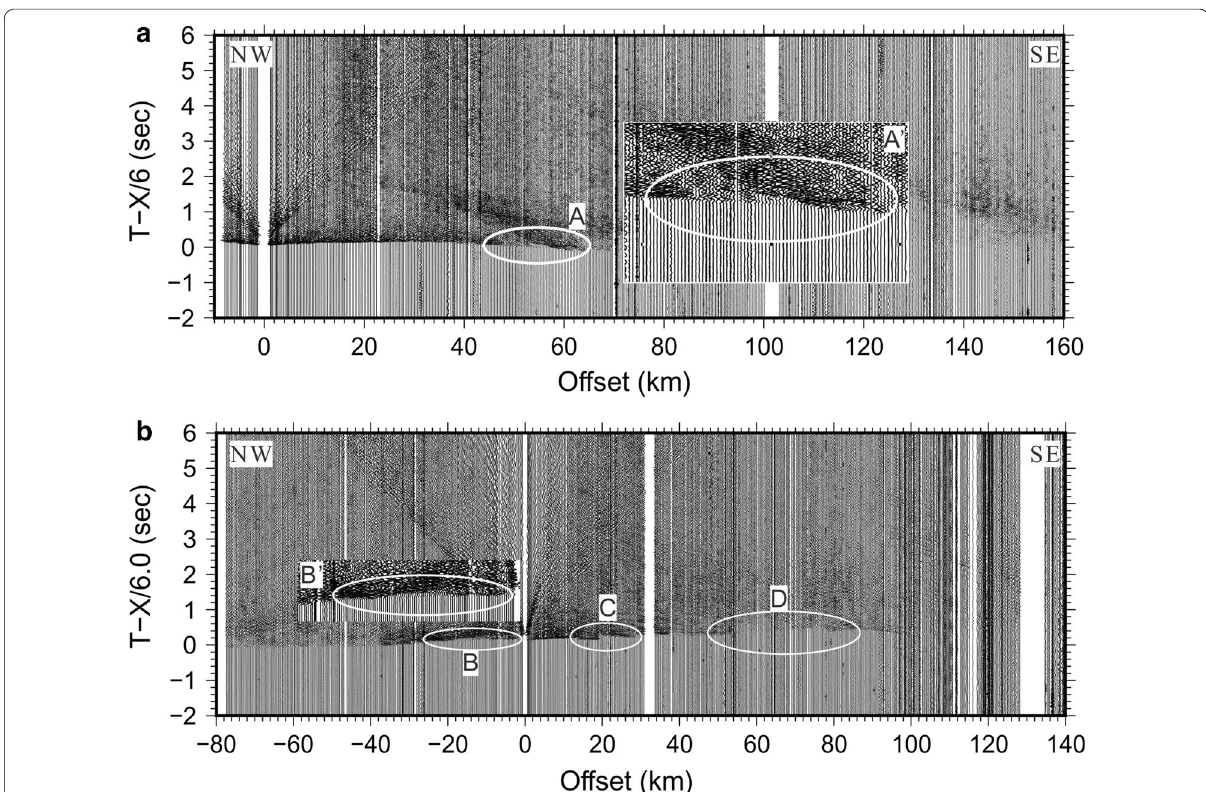
Fig. 6 a The record section of SP1. Region A ′ is the expansion of region A, showing that there is a strong reflection after the Pg phase. b The record section of SP3. Region B ′ is the expansion of region B, indicating there is a reflection after Pg. It is close to Pg, so it is possibly generated by the very shallow structure. Region C shows a step of Pg, and region D shows that there is a shadow zone between 60 and 80 km, indicating a low-velocity zone (LVZ) in upper crust (Park et al. 2010). Note that this LVZ is not the LVZ above (Figs. 3a, 5); rather this LVZ is much shallower and